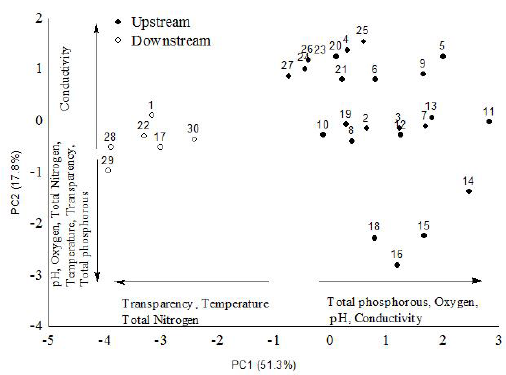
Figure 2. Principal Component Analysis (PCA) of the limnological variables for thirty floodplain lakes of the Araguaia